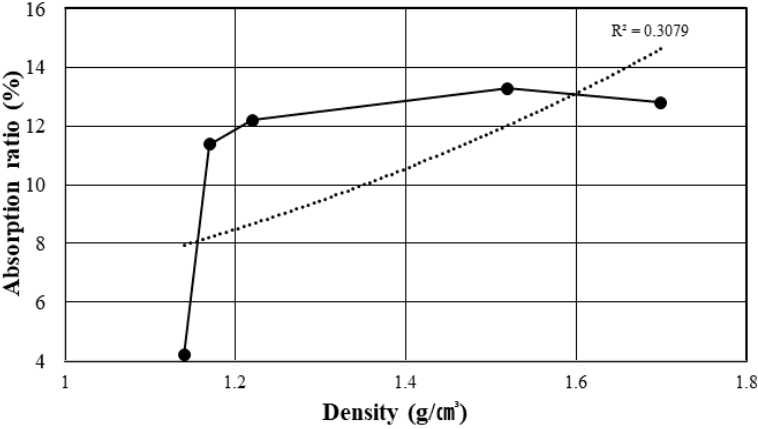
Figure 5. Relationship between the density and the absorption rate of dBA.